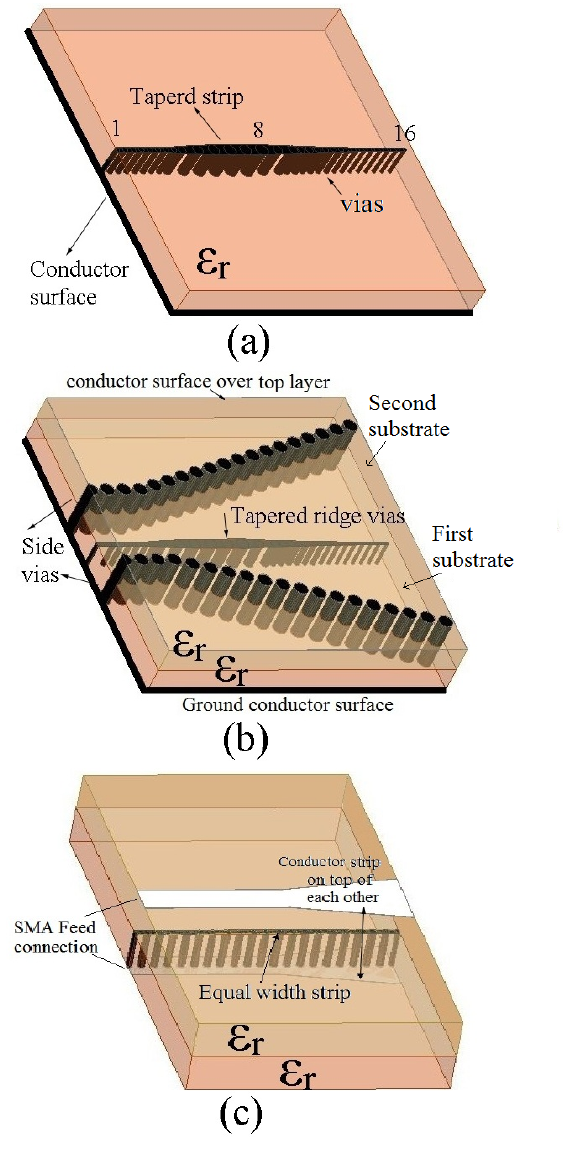
FIGURE 1. (a) The First substrate showing the tapered ridge (tapered strip on top of vias), (b) the second substrate on top of the first substrate with side vias from top to bottom and (c) feed section.